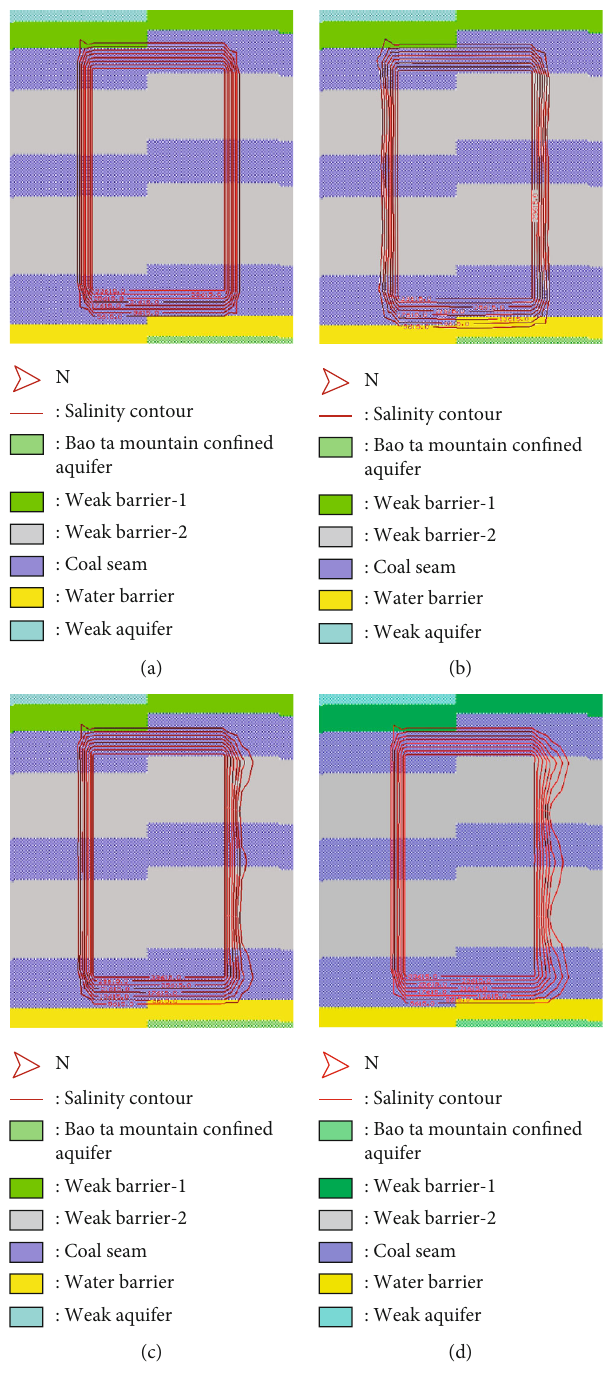
Figure 7: The migration of concentrated brine to the north side under di ff erent groundwater head di ff erences after long-term penetration for 30 years (the model is stretched 20 times the actual vertical direction, (a) is the initial state, (b) is 10meters, (c) is 50meters, and (d) is